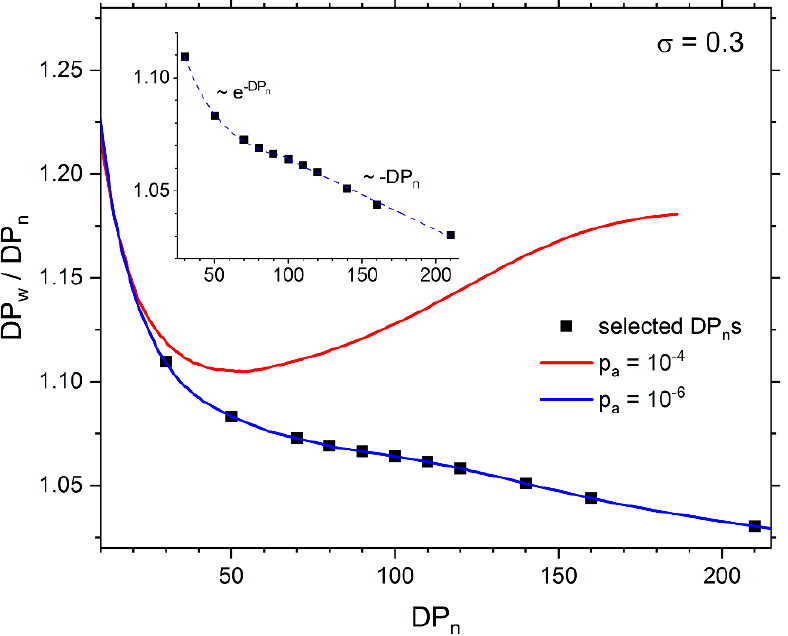
Figure 3. The dispersity DP w / DP n versus the number-averaged degree of polymerization DP n . The system structure in equilibrium can also be analyzed by the scaling behavior of chain sizes. Figure 4 shows the dependencies of the mean squared end-to-end distance R 2 ee , vs. chain length m (number of segments or DP for single chain) , and for various values of DP n on a double logarithmic scale. It is impossible to determine the scaling exponents because the plots presented in Figure 4 are not linear. One can recognize that for very short chains ( m < 20) the scaling exponent is close to 1 whereas for intermediate lengths (50 < m < 100) the dependence of R 2 ee on chain length is considerably stronger. This unexpected scaling comes from a variety of states of shorter chains (coiled) and longer chains (extended). What is interesting here is that the size of the longest chains for high DP n , i.e., for systems where the pairs of brushes are in contact, is almost independent of the chain length. This confirms that the brushes do not interpenetrate significantly and that the compression effect for the brushes prevails. A detailed analysis of the dependency of the main parameters describing the brush on DP n was recently carried out [57]. It was shown that the mean chain height and radius of gyration exhibit two scaling regimes. The first region was found for brushes with DP n ≤ 100 and the scaling exponent was considerably higher than for single free chain [76] and very close to the exponent of rods. In the second regime, an unexpected scaling behavior was found, with scaling exponent below 1, which can be interpreted as a size increase for short chains with increasing DP n along with compression of longer chains, resulting in flower conformations. This suggested the mutual interaction of both brushes for systems with DP n >